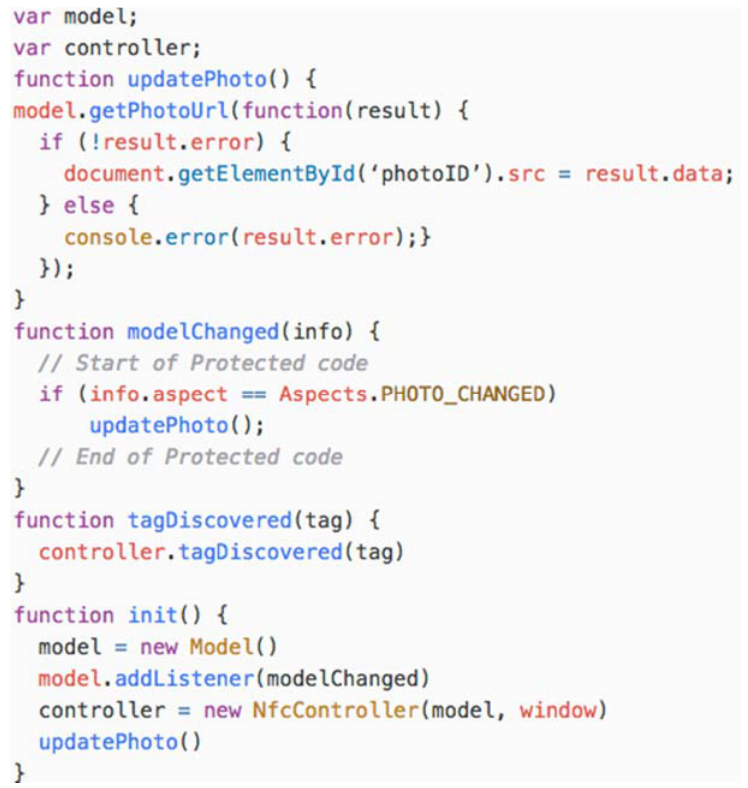
Figure 8. The view.js JavaScript file.